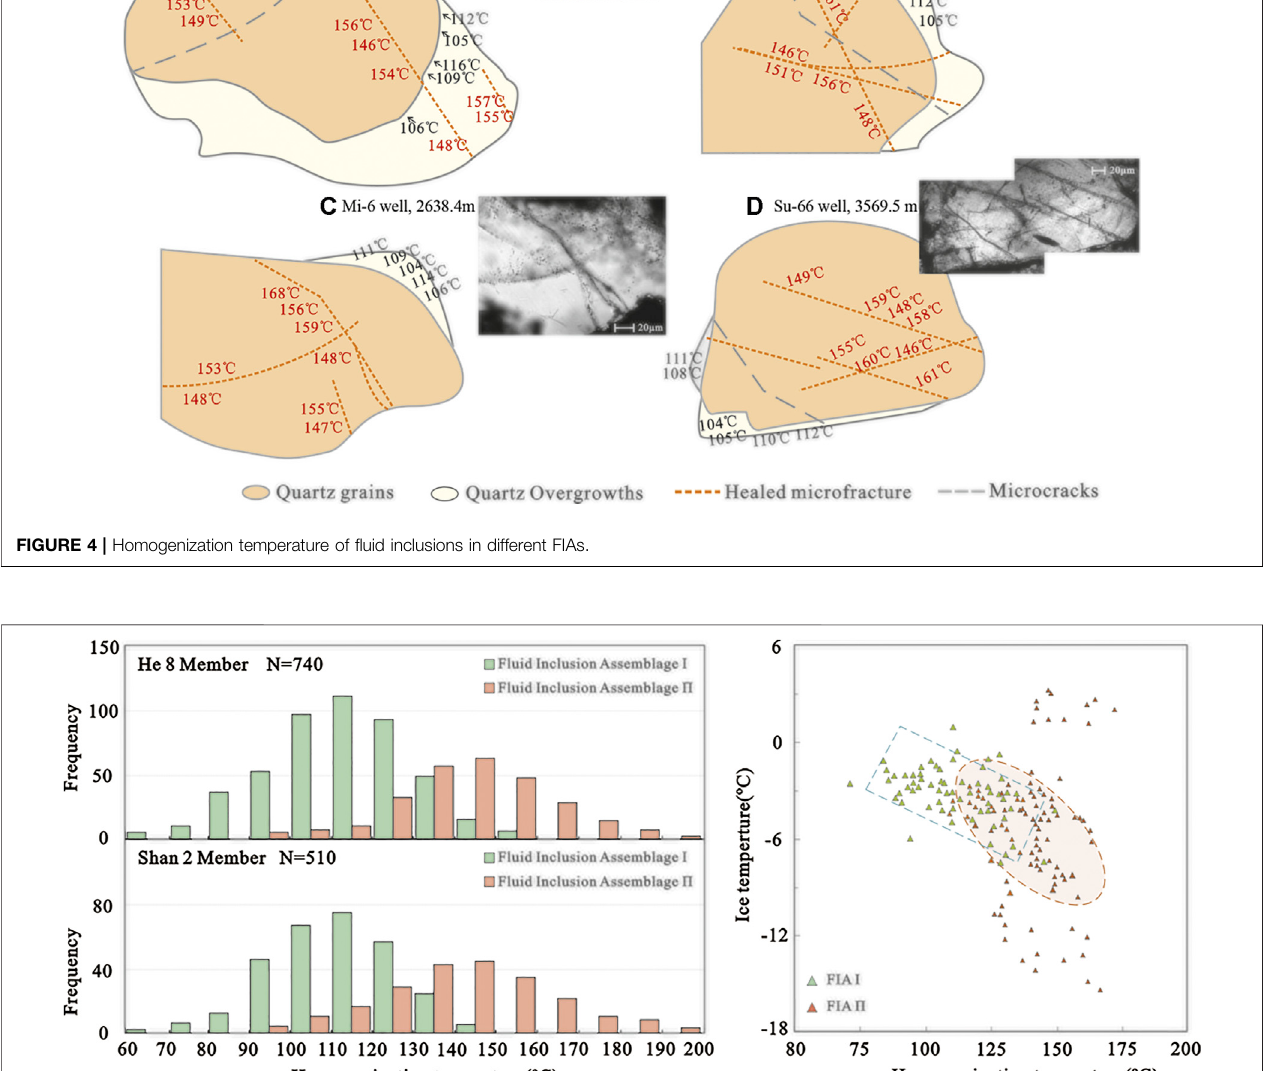
Frontiers in Physics |